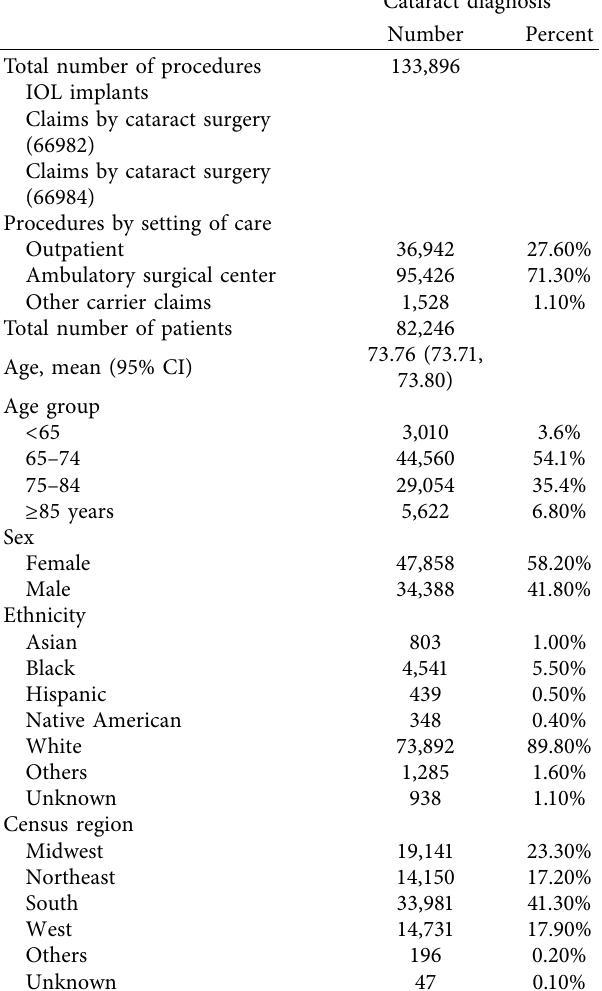
Table 2: Comorbidities of Medicare fee-for-service patients un- dergoing cataract surgery.